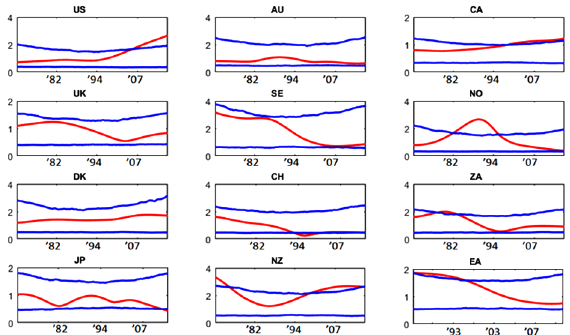
Figure 6. Estimates of the wavelet gain coefficients for house prices with respect to M3 – mean values in the interval of 8–16 years and their constancy tests in 1970–2016 (source: own work)